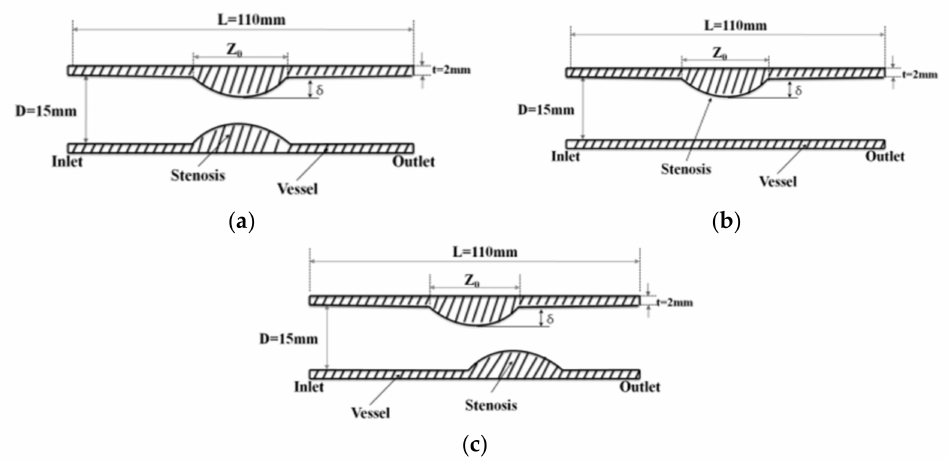
Figure 8. Geometry of the stenosed blood vessel. ( a ) Model 1, ( b ) model 2, and ( c ) model 3. δ = depth of stenosis.